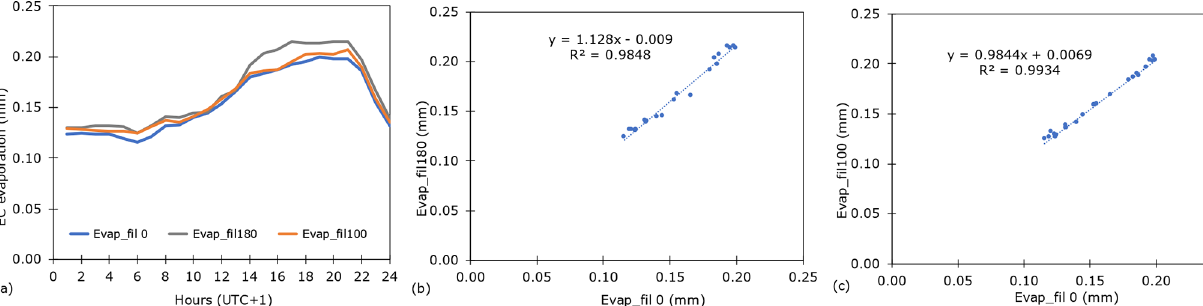
Figure 3. (a) Daily cycle of the eddy covariance (EC) evaporation ( E EC ) with and without wind direction filters; (b) correlation between the EC evaporation with a 180 ◦ wind direction filter (“Evap_fil180”) and without the filter (“Evap_fil 0”); (c) correlation between the EC evaporation with a 100 ◦ wind direction filter (“Evap_fil100”) and without the filter (“Evap_fil 0”), for Alqueva-Montante station from June to September